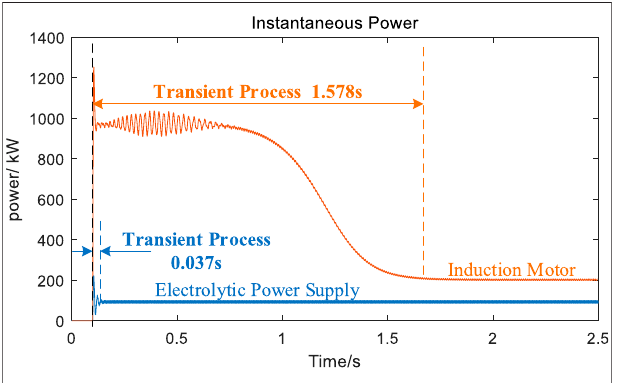
FIGURE 2 | Instantaneous power during equipment starting.